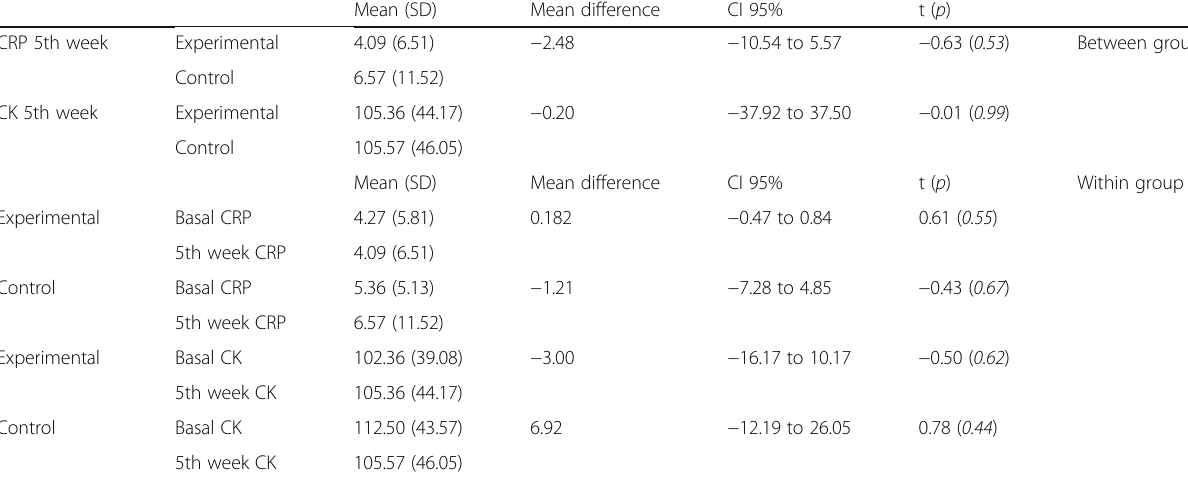
Table 6 Change scores between-group and within-group in biological outcomes Mean (SD) Mean difference CI